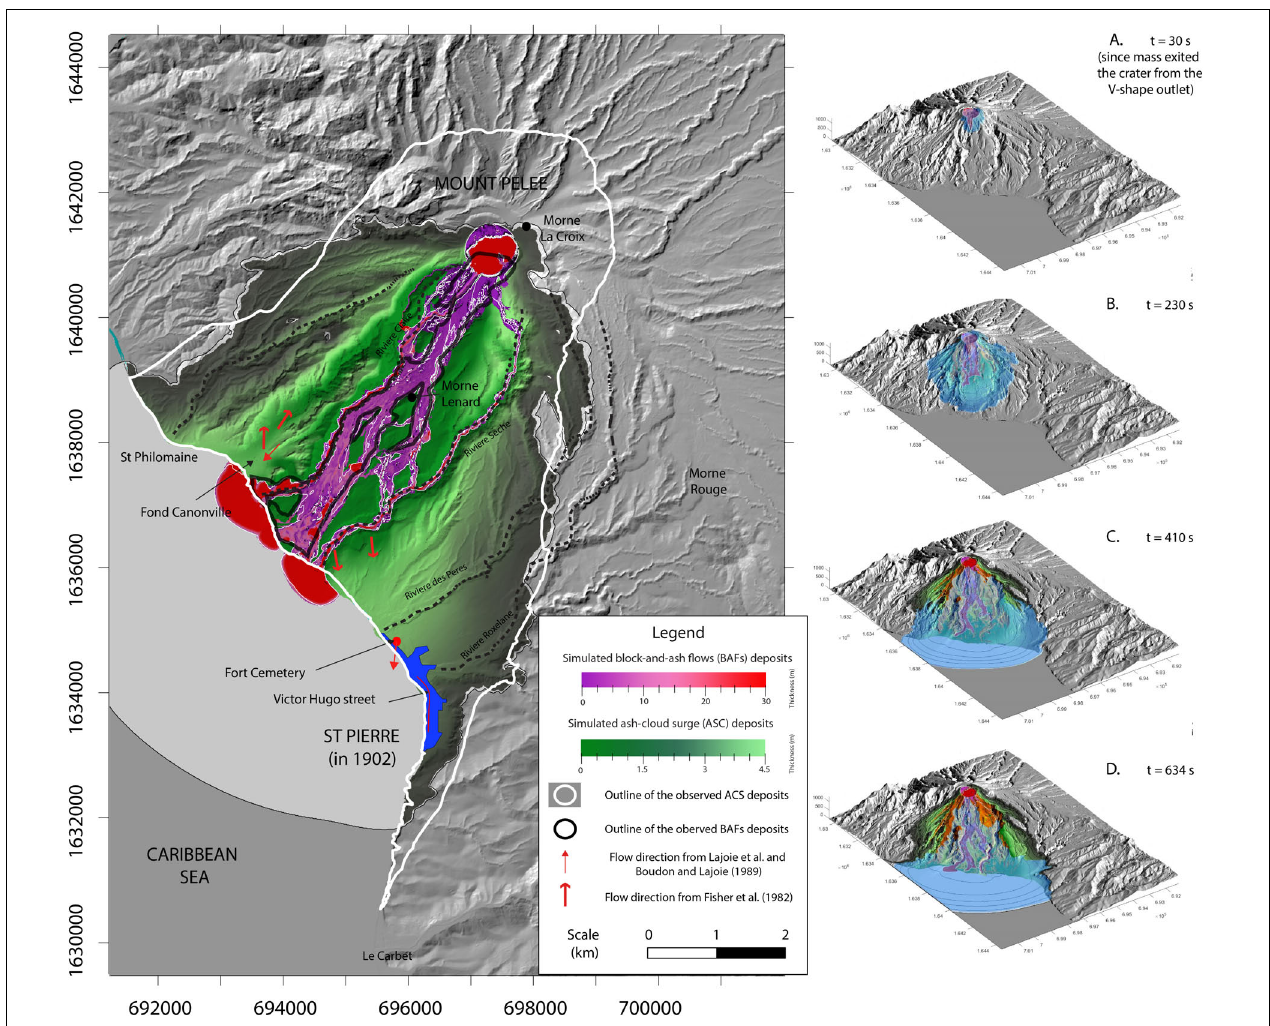
FIGURE 7 | Results of the best fit simulation obtained using the input parameters presented in Table 2 . (A) Final distribution of the simulated deposits from the best-fit simulation, which include the extent of the simulated ash-cloud surge (green color scale for the thickness) and the simulated block-and-ash flow (pink color scale). For ease of comparison, outlines of the observed ash-cloud surge and block-and-ash flow, as extracted from the field, have been added with a white and black outline, respectively. (B–E) Sequence of four snap shots of the best-fit simulation at 30, 230, 410, and 634 s after the mass starts to overflow through the crater outlet, showing the propagation of the flows overlain on the